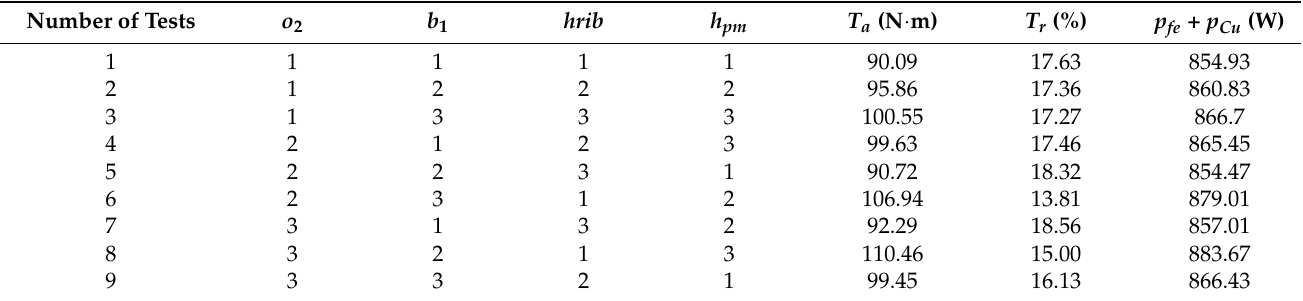
Table 7. L 9 (3 4 ) orthogonal test table and FEA